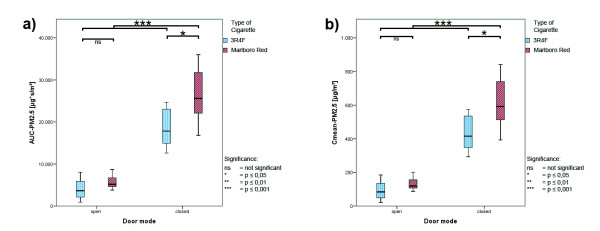
Boxplots of ETS exposure; emission period. a) AUC-PM2.5; b) Cmean-PM2.5 for 3R4F and Marlboro Red cigarettes; data were analyzed under open- and closed-door conditions.